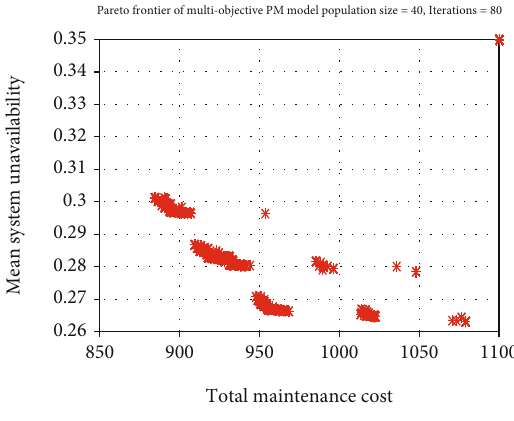
Figure 7: Approaching Pareto